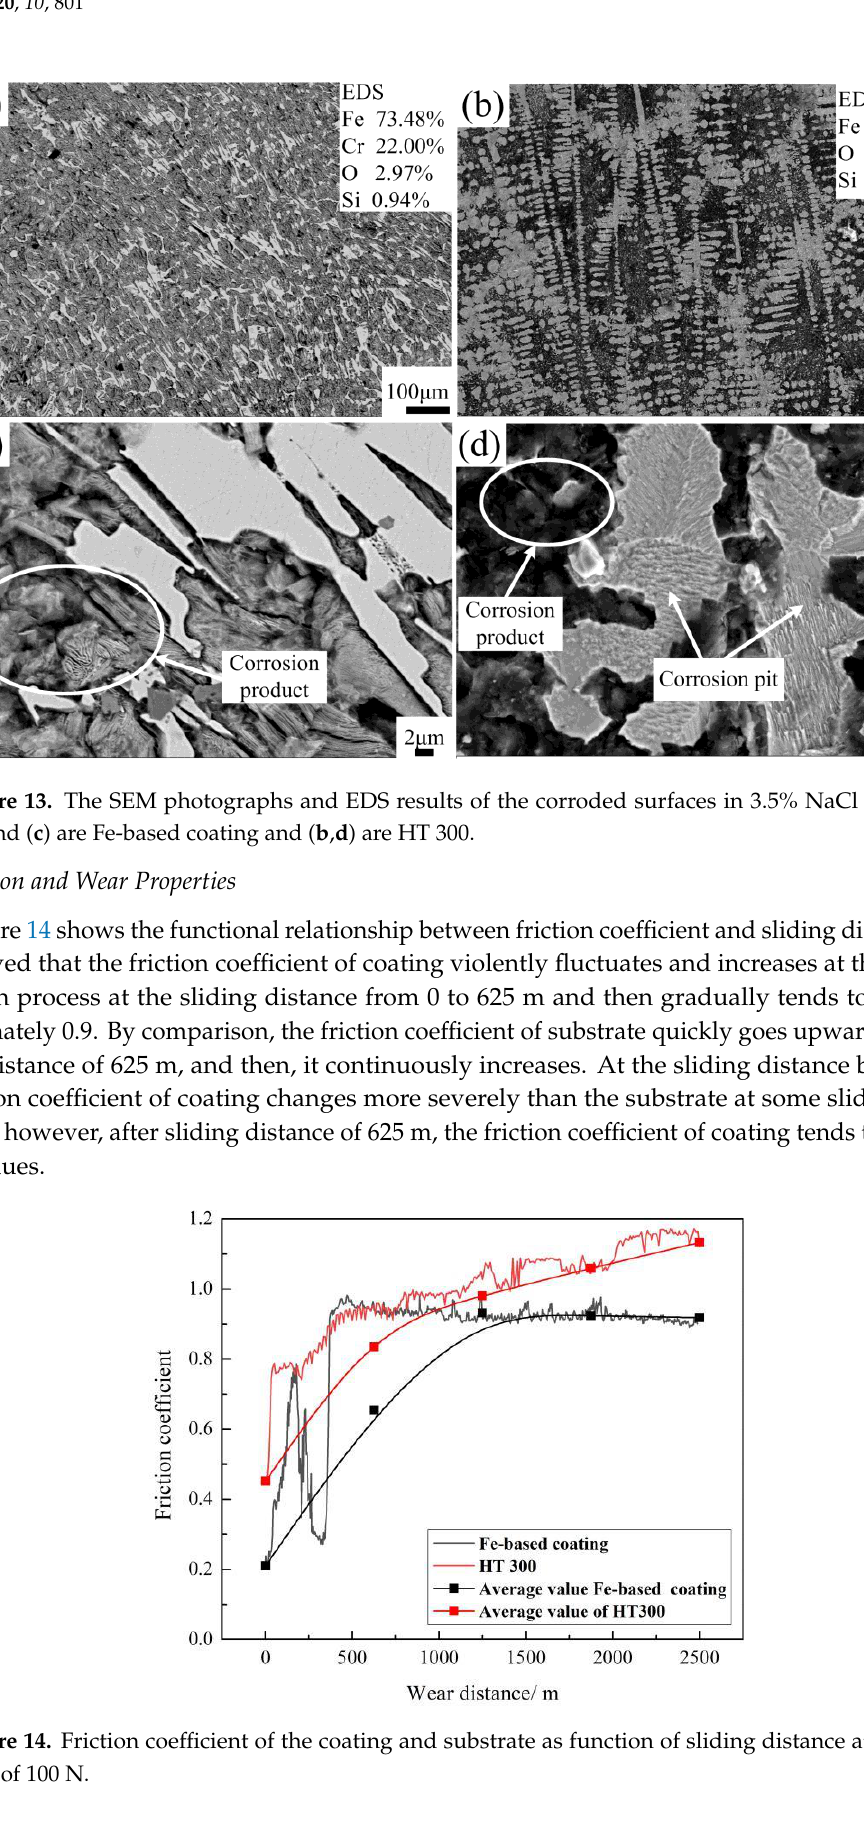
Figure 15. Wear loss of coating and substrate as function of sliding distance at a given load of 100 N. The morphology of worn surface of coating is shown in Figure 16a–c. After the sliding distance of 625 m, minor furrows appear along the friction direction on the coating surface, and the wear mechanism in this stage is dominated by light abrasive wear. When the sliding distance reaches 2500 m, the deep groove occurs and a quantity of wear products cover on the coating surface. Meanwhile, some spots of debris powder are agglomerated onto the coating surface. Referring to the EDS results (Table 5), the dark region and wear debris primarily consist of oxides, and the white region consists of the original chemical composition of Fe-based coating. With the increase in sliding distance, the wear debris is oxidized under the role of friction heat and air and firmly attached onto the coating surface. In accordance with the analysis of wear behavior, it can be observed that after the sliding distance of 625 m, the friction coefficient of coating tends to be stable and the wear losses increase slowly. It can be assumed that the wear products firmly cover on the coating surface, which, in turn, improve the wear resistance [23]. To conclude, the wear mechanism of coating is mainly dominated by abrasive wear and oxidation wear. In contrast, the worn surface of substrate suffers sever adhesive wear, presenting plastic deformation and deep groves after sliding distance of 2500 m, as shown in Figure 16d. Some small craters and large size debris can be obviously seen on the coarse wear surface of substrate. Because the graphite flakes and the matrix around the graphite flakes can be easily peeled off, rough wear surface and some craters are generated, which, in turn, lead to the violent fluctuation of friction coefficient and a high mass loss. The main wear mechanism of the substrate is the predominant fatigue wear [24].